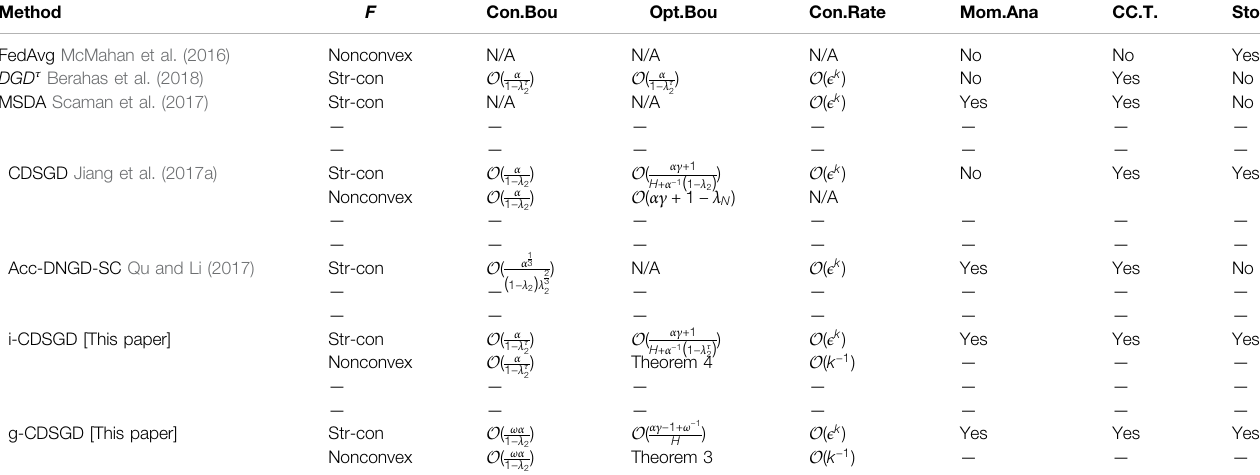
TABLE 1 | Comparisons between different optimization